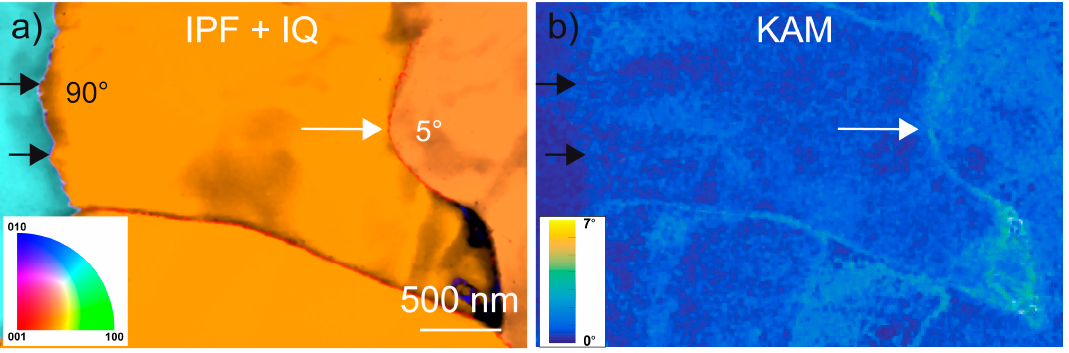
Figure 4. M642 SGB (arrows in white) and GB (arrows in black). ( a ) IPF corresponding to the direction normal to the plane of representation, superimposed with the IQ (Equation (1)); color code inserted ( Pnma ). The SGB arrow in white has a misorientation of 5°, and the GB arrow in black has a misorientation of 90°. ( b) Kernel average misorientation (KAM) map corresponding to ( a ), up to 7°.